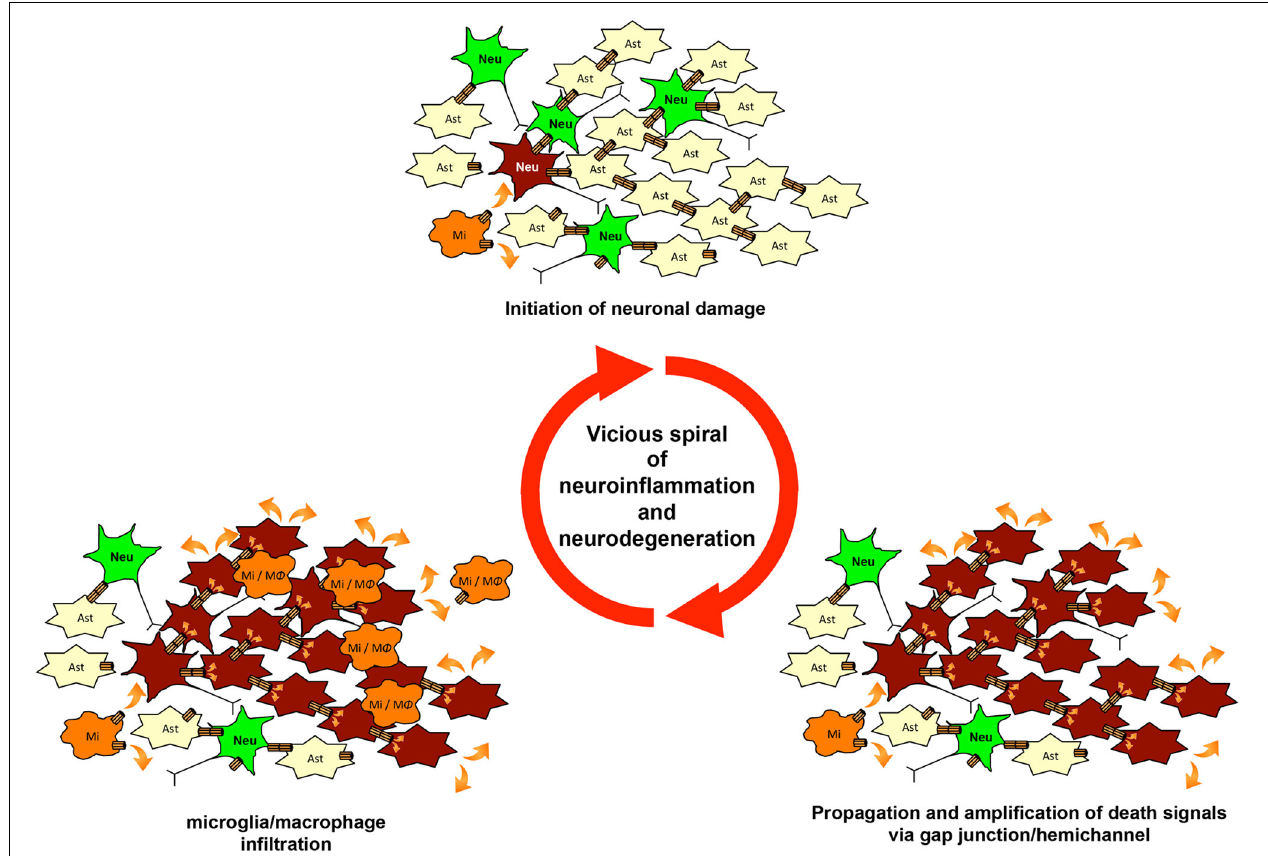
FIGURE 3 | The vicious spiral of neuroinflammation and neurodegeneration mediated by gap junctions and hemichannels. Microglial glutamate release via hemichannels initiates neuronal damage. Then, waves of death signals are propagated and amplified via glial and neuronal gap-junction communication. Chemoattractants from damaged cells